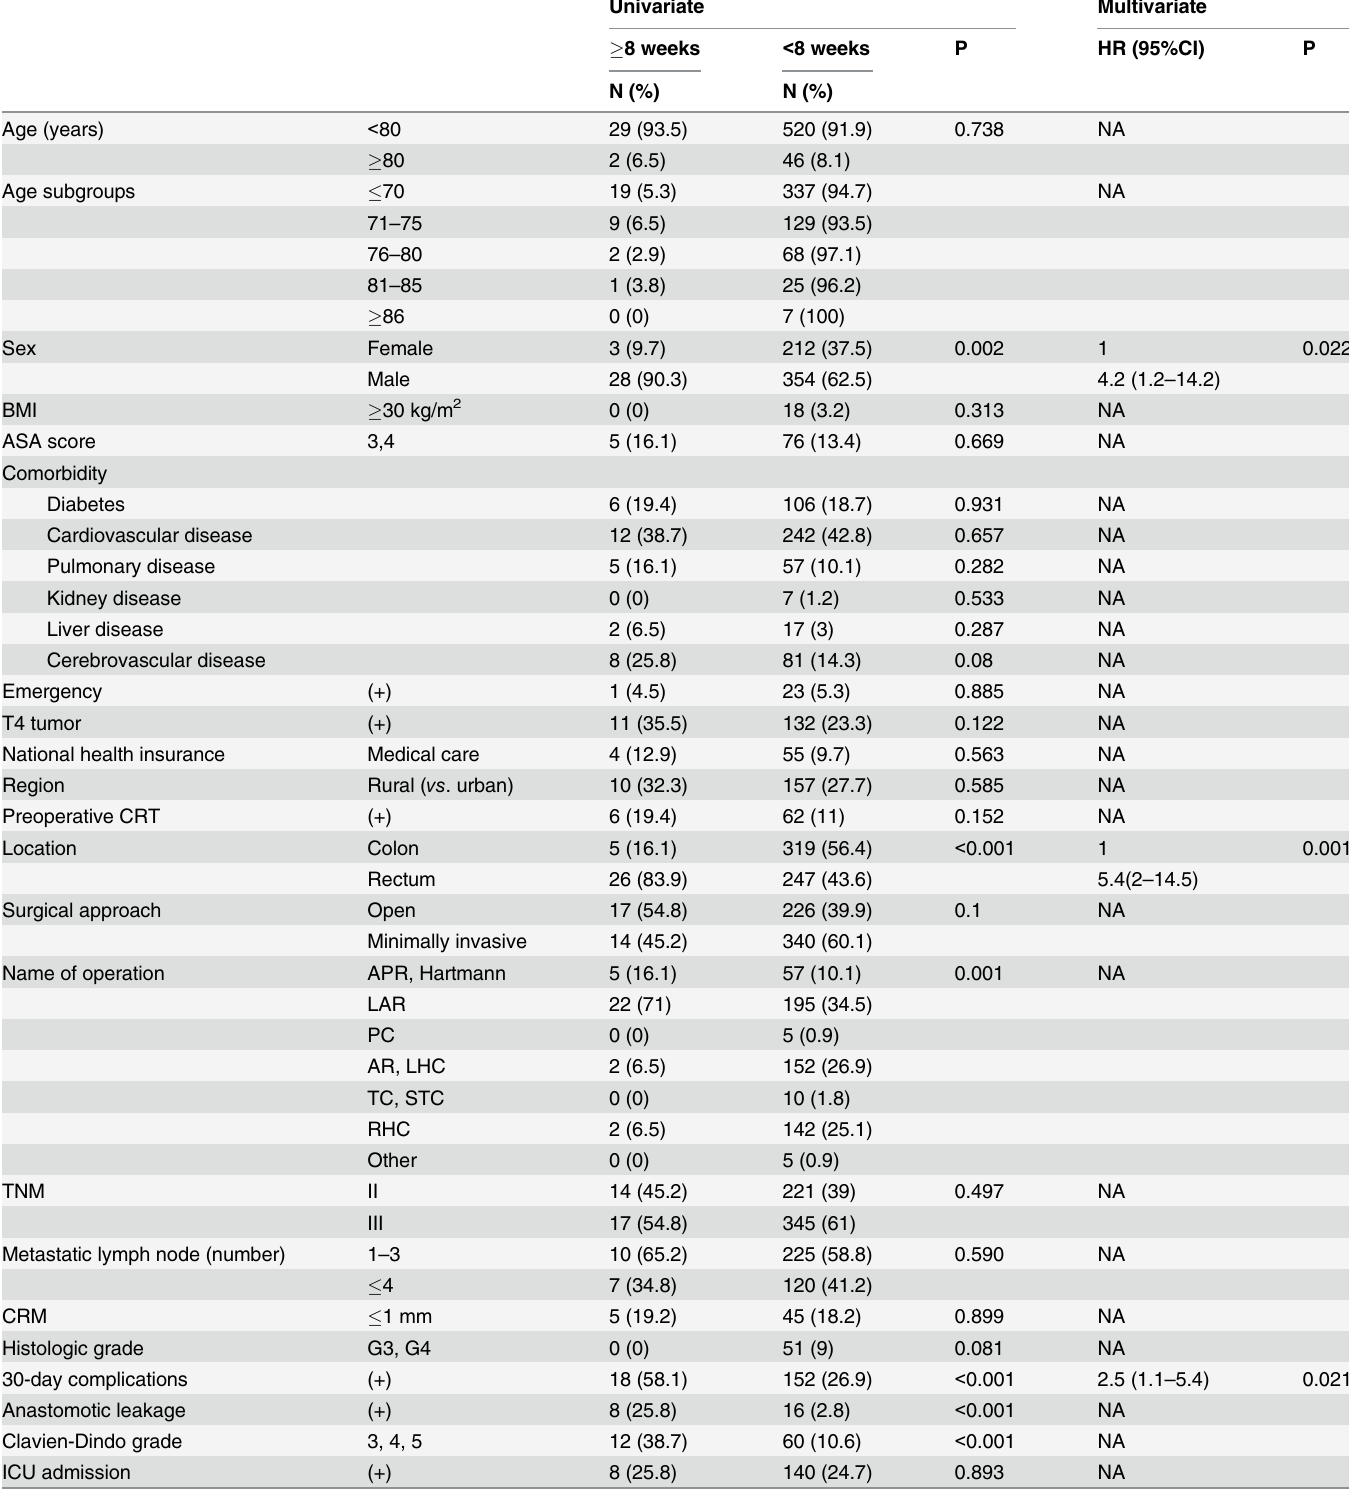
Table 3. Factors associated with a (cid:1) 8-week delay to adjuvant chemotherapy (n = 597). Univariate